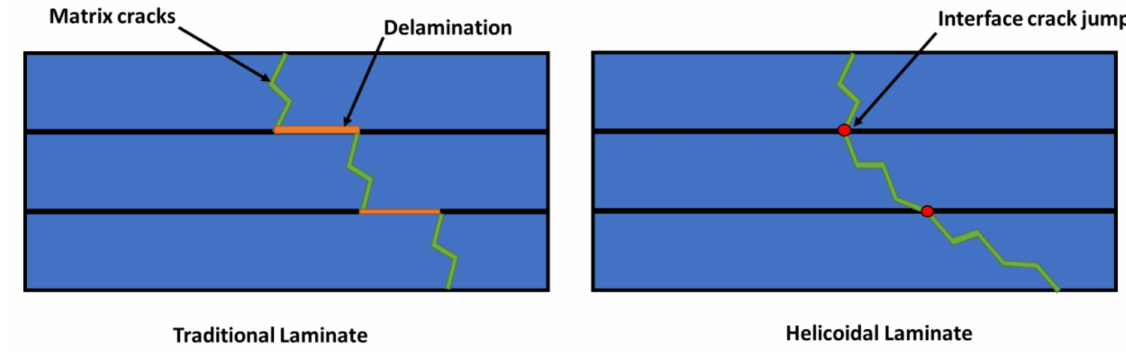
Figure 1. Illustration of the crack twisting mechanisms of a helicoidal laminate’s